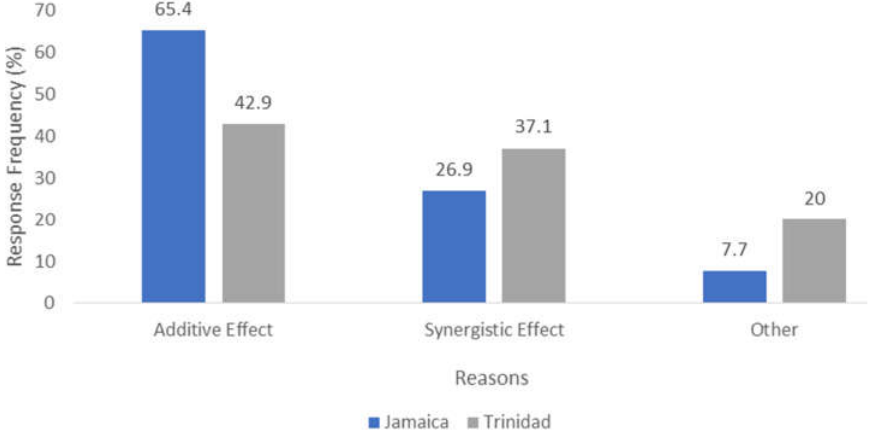
Figure 3. A bar chart showing the reasons for antimicrobial combination therapy in Trinidad vs. Jamaica. Table 2. The association between country and the choice of antimicrobial agent in small animal clinics in Trinidad and Jamaica.